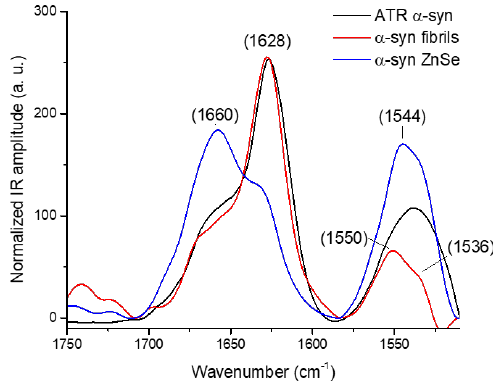
Figure 7. AFM-IR spectra of the α -synuclein di ff erent species, normalized on the area of the amide I band. The red curve corresponds to the fibrils on the ZnS prism. The blue curve corresponds to fibrils from the same batch deposited on the ZnSe prism. The topography of the di ff erent species is available in Figure 6a,b respectively. The black curve is the reference spectrum for fibrils obtained by